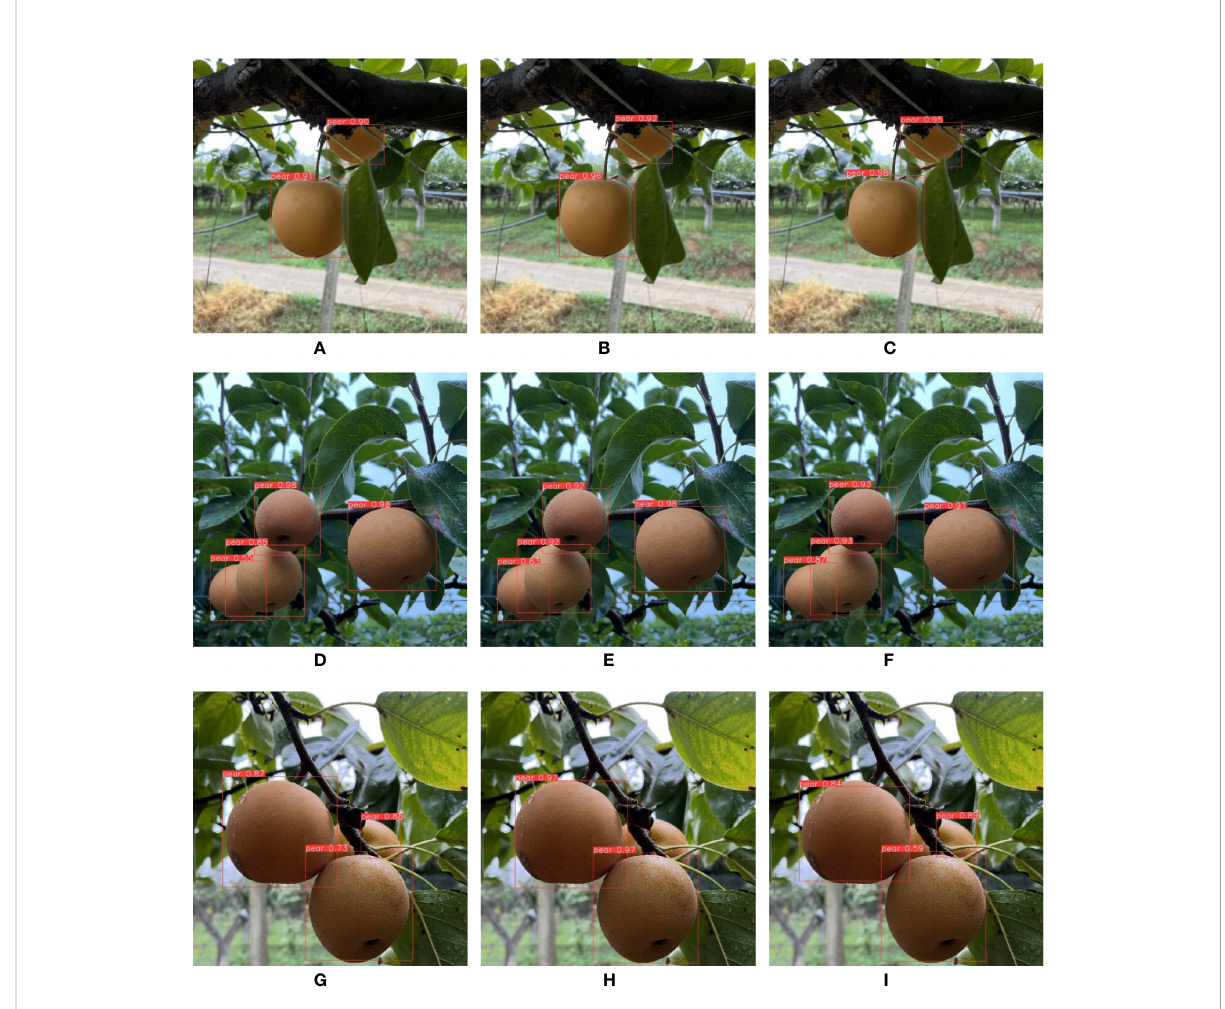
FIGURE 9 From left to right are the detection effects of YOLOv5s, MobileNet-YOLO and YOLO-P. (A – C) No shaded or slightly shaded; (D – F) Medium shaded; (G – I) Serious